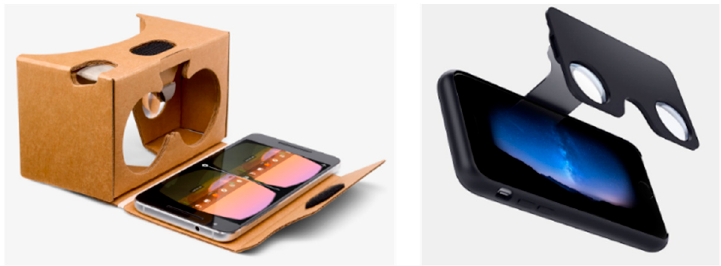
Figure 1. Typical mobile virtual reality with the smartphone inserted and closed into an inexpensive headset ( left ), and “EasyVR” in which light magnifying lenses are clipped on the smartphone in a non-isolating way.